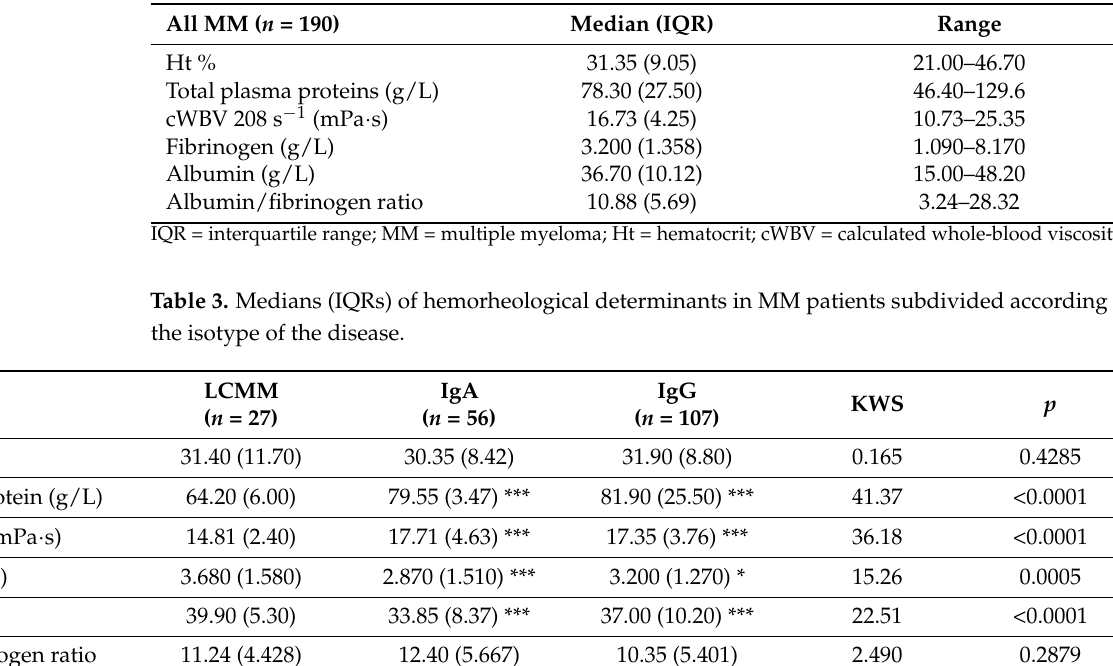
Table 2. Medians, IQRs, and ranges of hemorheological determinants in MM patients.